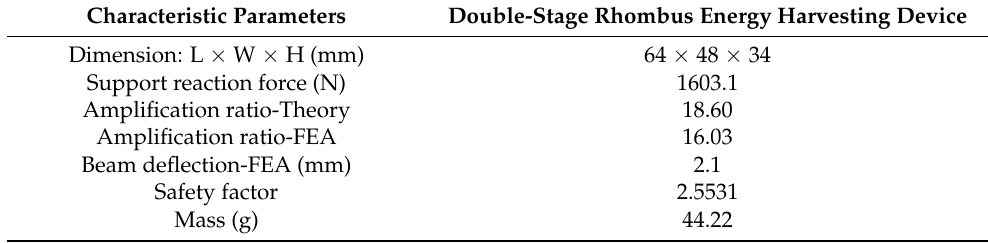
Table 8. Characteristic parameters of the double-stage rhombus energy harvesting